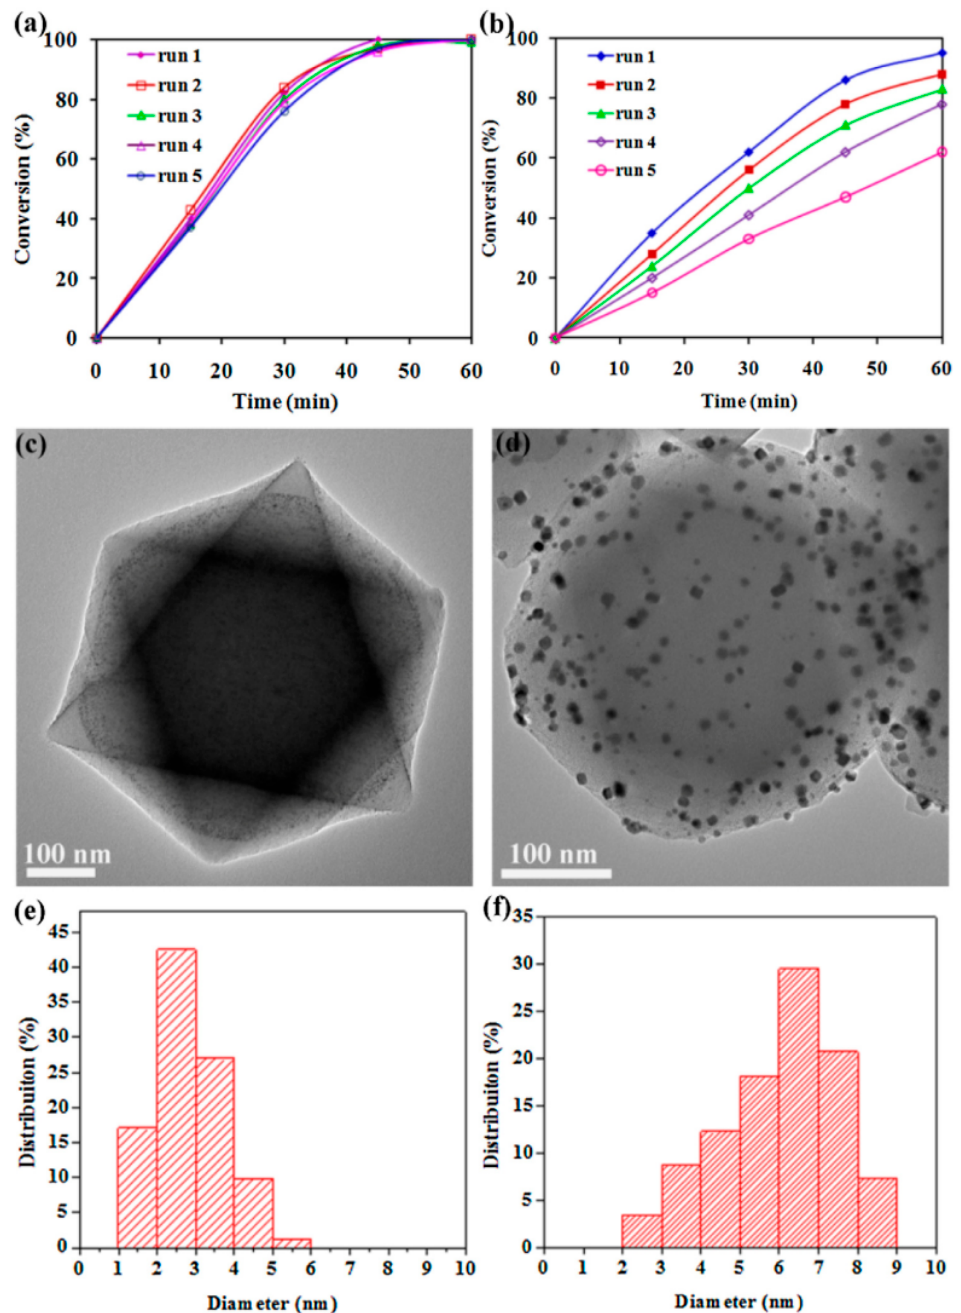
Figure 14. Reusability of the Pt 8 Co 1 @UiO-66(Zr) ( a ) and PtCo / UiO-66(Zr) (8:1) ( b ) in the hydrogenation of nitrobenzene. TEM images and corresponding particle-size distribution histograms of the recycled Pt 8 Co 1 @UiO-66(Zr) ( c , e ) and PtCo / UiO-66(Zr) ( d , f ) after being used five times. Reproduced with permission from [63].